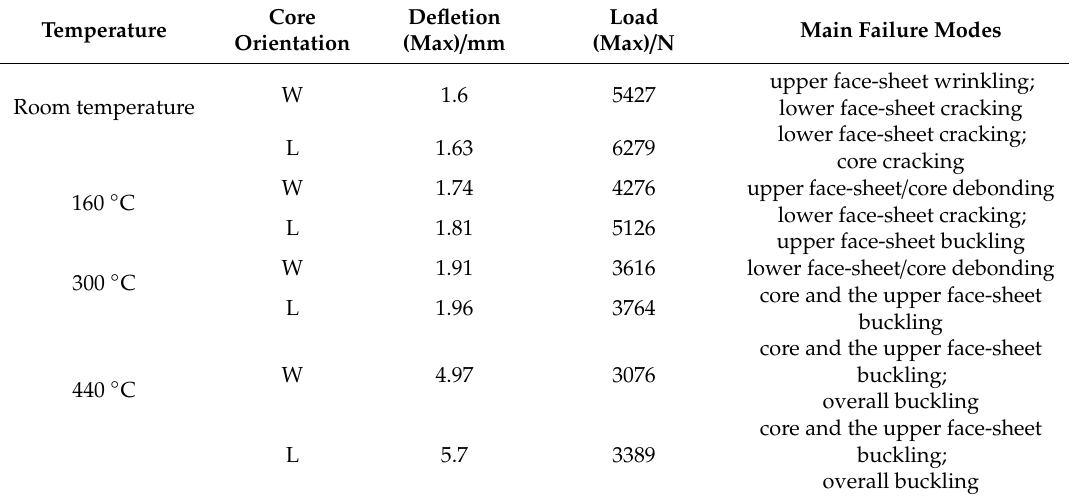
Table 5. Flexural properties and failure modes of the vented honeycomb sandwich panels.